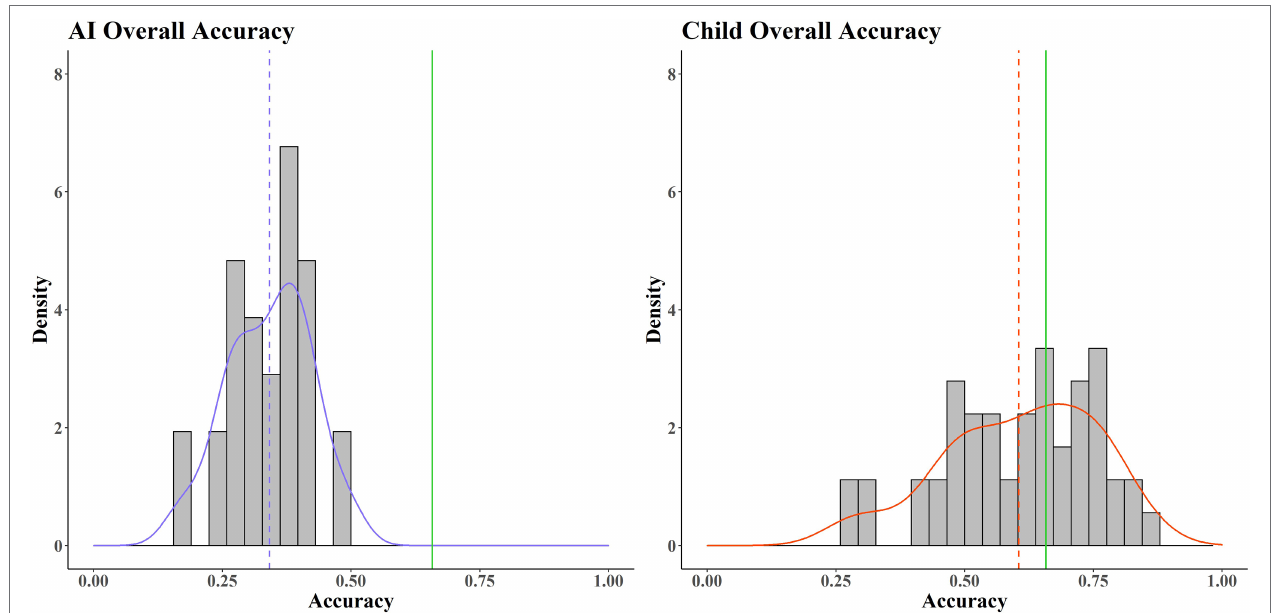
FIGURE 2 | Histograms of accuracy averaged across 40 tasks. AIs ( left , purple) and children ( right , red). The average pass mark across the 40 tasks is shown by the green line. Red/purple solid lines show the probability densities. Red/purple dotted lines show average